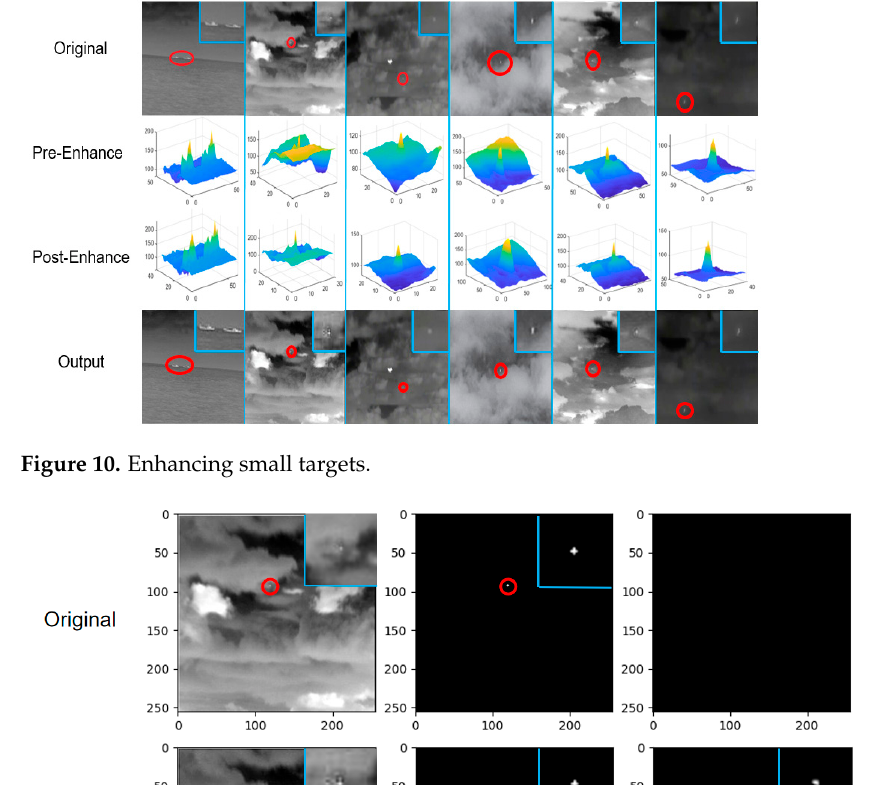
Figure 11. Detection results before and after sharpening.